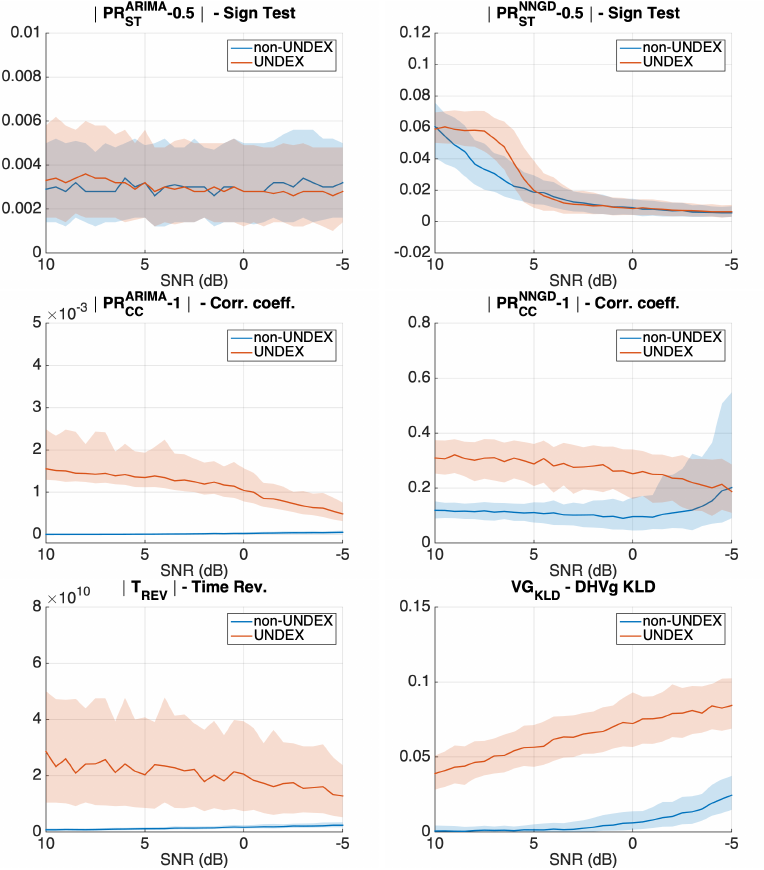
Figure 6. Evolution of all the presented metrics in simulated events when the SNR decreases (Y axis in arbitrary units). The results were obtained for 500 Monte Carlo runs for events clipped to 50% of their maximum